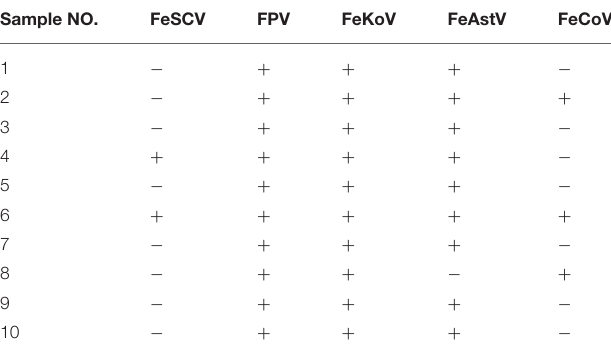
TABLE 1 | Results of multiple virus tests on cat fecal samples. Sample